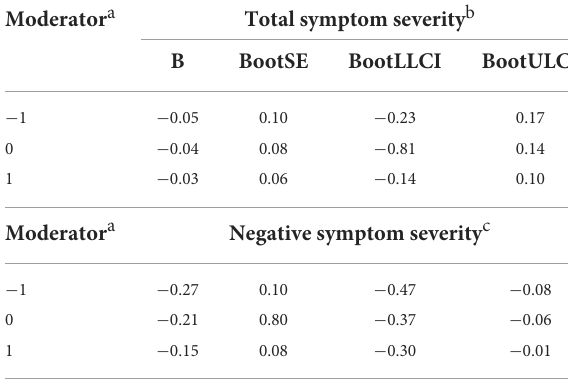
TABLE 5 Conditional effects of mindfulness at values of self-compassion.